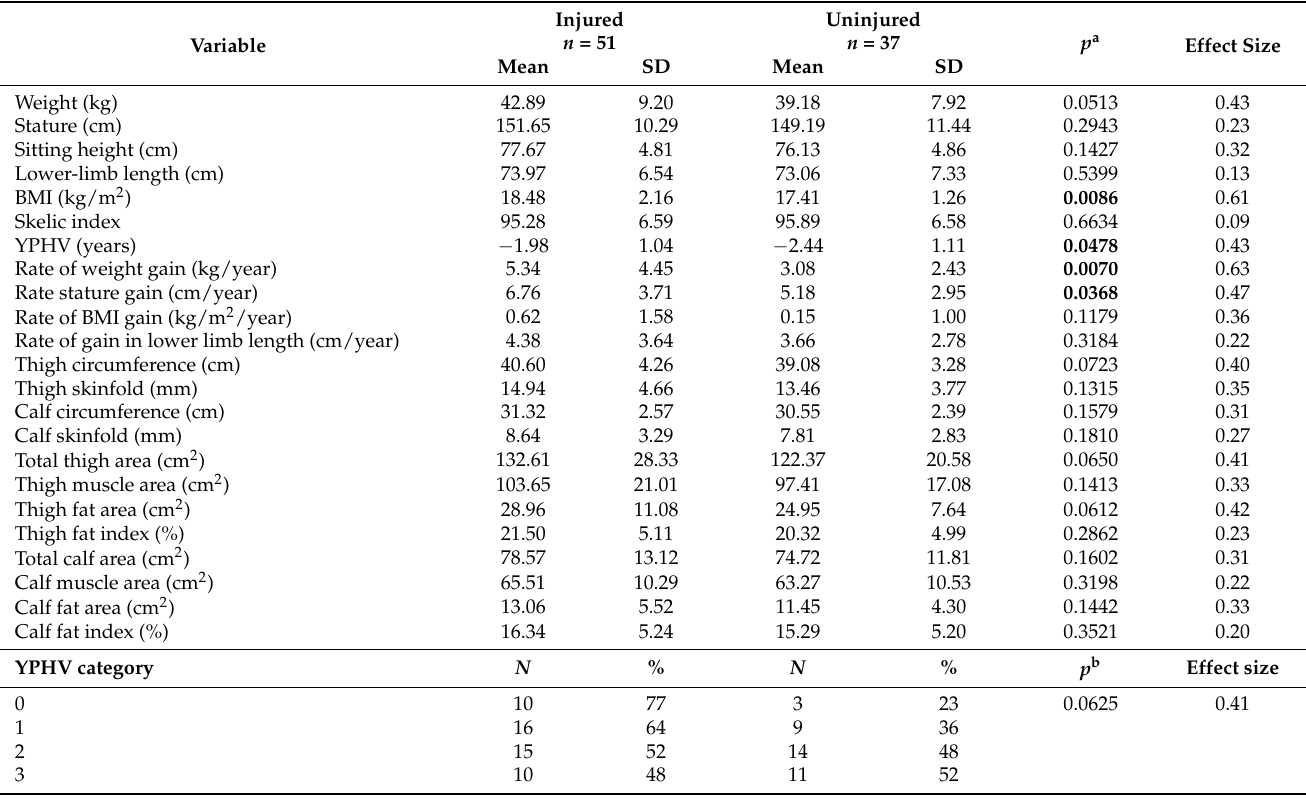
Table 3. Comparison between injured and uninjured youth soccer players by risk factors. The anthropometric characteristics and growth rate during the second survey are presented above, whereas the distribution of injured/uninjured players according to their biological maturity (YPHV categories) is presented